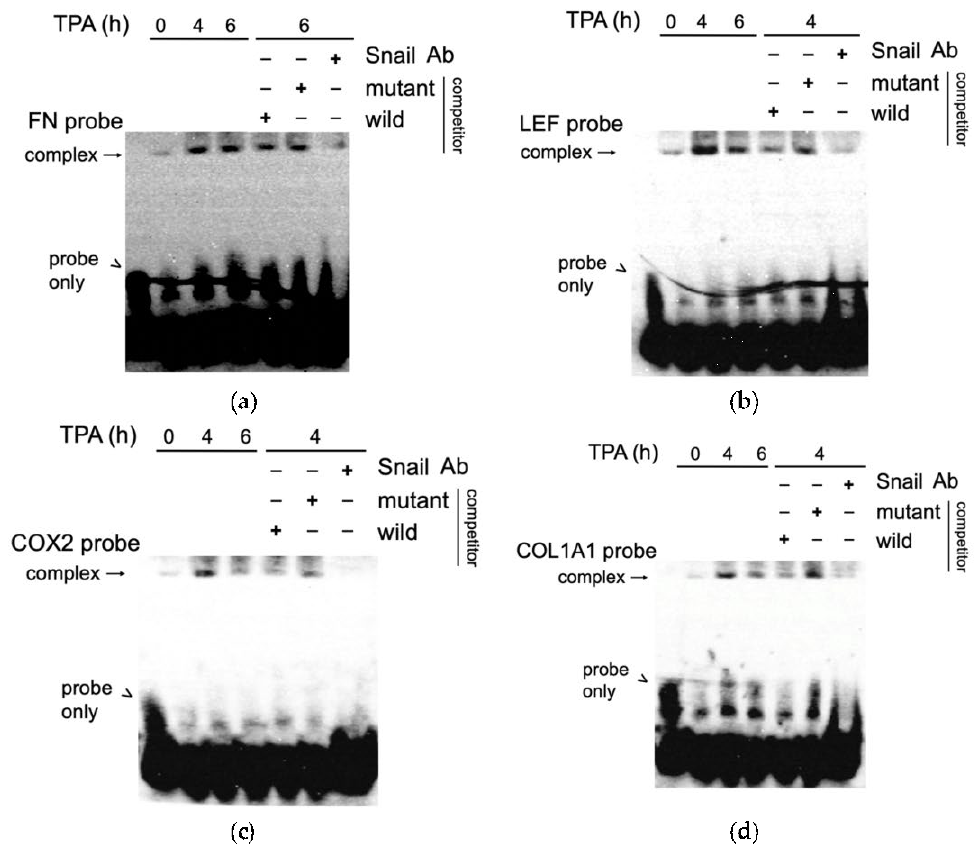
Figure 6. EMSA for TPA induced binding of SNA on putative regions of FN, LEF, COX2, and COL1A1 promoter. Nuclear extracts obtained from HCC340 treated with 50 nM TPA for the times indicated were used for EMSA for promoter fragment of FN (FN probe) ( a ), LEF (LEF probe) ( b ), COX2 (COX2 probe) ( c ), and COL1A1(COL1A1 probe) ( d ). Unlabeled wild-type or mutant competitors in 200X amount were included in the EMSA using nuclear extracts from HCC340 treated with TPA for 6 h (for FN probe) or 4 h (for LEF probe, COX2 probe, and COL1A1 probe). Lane 1 is the sample of probe only. For antibody inhibition, SNA antibody was preincubated with the nuclear extract from HCC340 treated with TPA for 6 h (for FN probe) and 4 h (for LEF probe, COX2 probe, and COL1A1 probe), followed by EMSA reaction. The data shown are representative of two reproducible experiments.